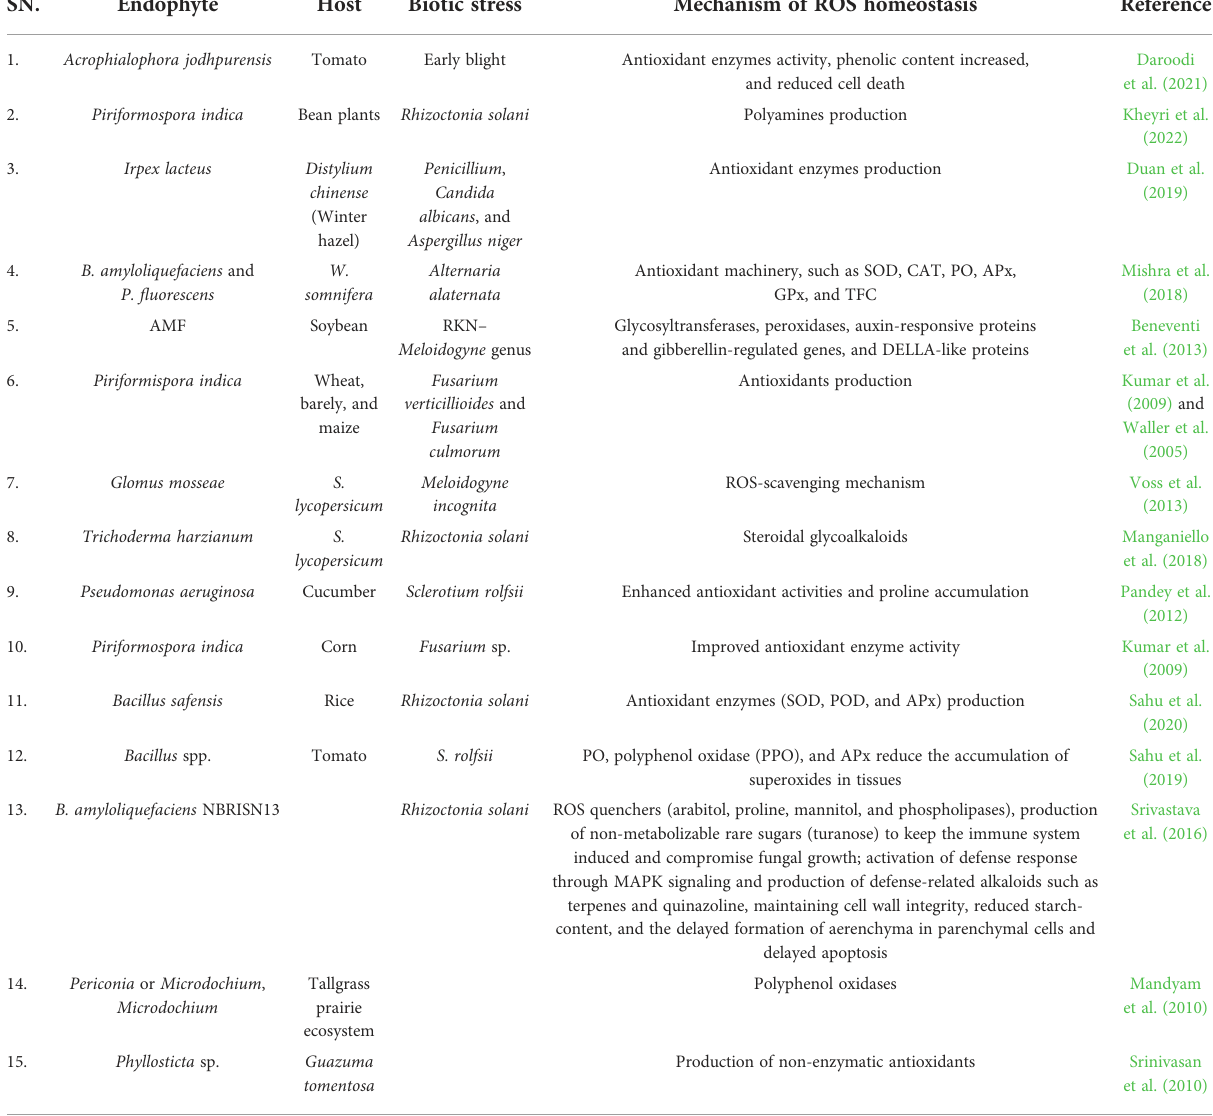
TABLE 2 Mechanism of ROS homeostasis by the endophytic microorganisms in plants.